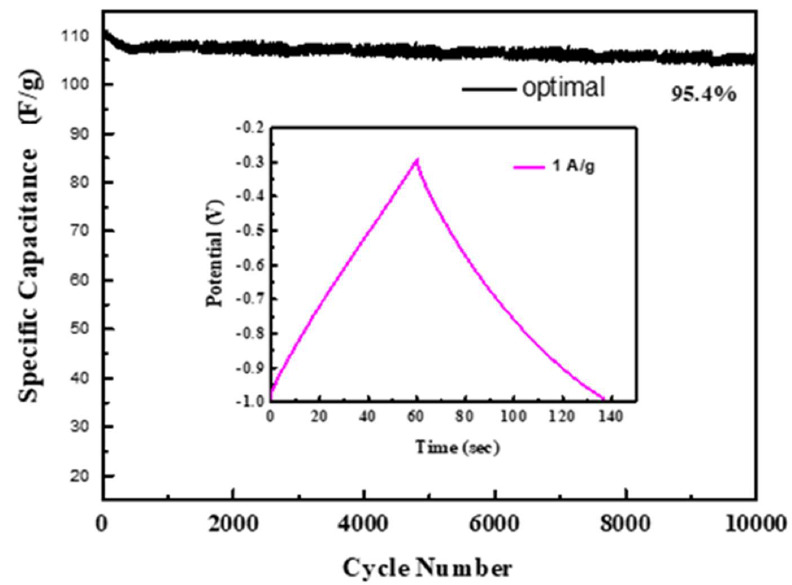
Figure 9. The retention efficiency of the optimal electrode.